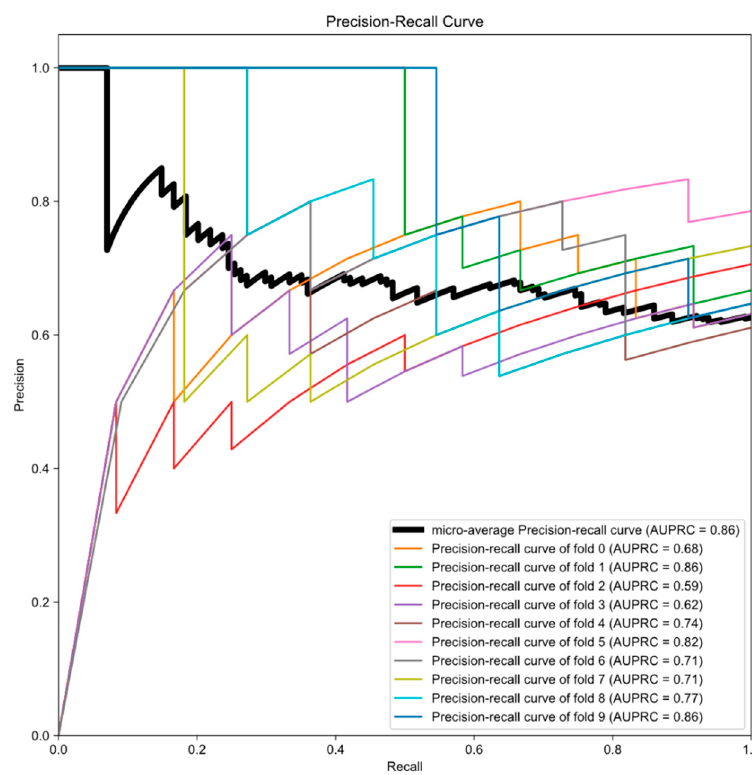
Figure 3. Precision-recall curves generated by 10-fold cross validation. Deep learning algorithm was the finalized optimal parameter in the whole dataset (the SNUH dataset plus the KROG dataset). Thick black line indicates the micro-average precession-recall curve, and the area under the precision-recall curve (AUPRC) is also represented in each graph.